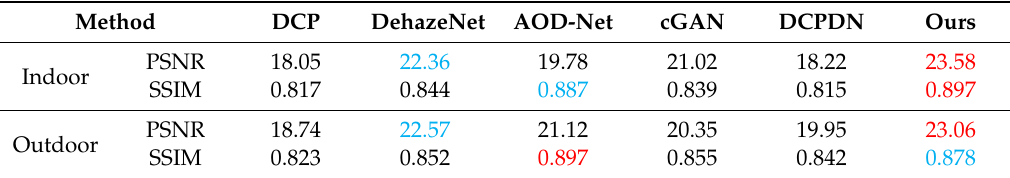
Table 1. Average Peak Signal-to-Noise ratio (PSNR) and Structural Similarity Index Metric (SSIM) results on SOTS (Synthesis Object Testing Set). (red font indicates the highest value, followed by blue